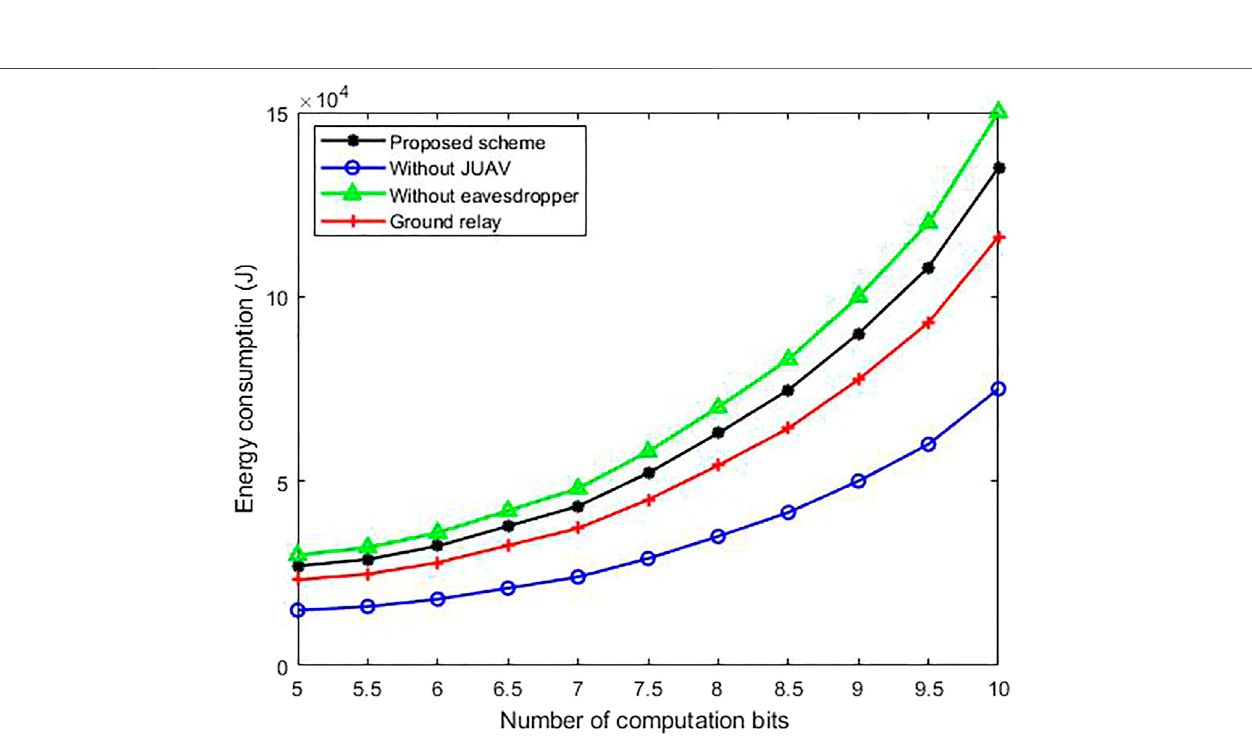
FIGURE 4 | Energy consumption vs. the number of calculated bits.